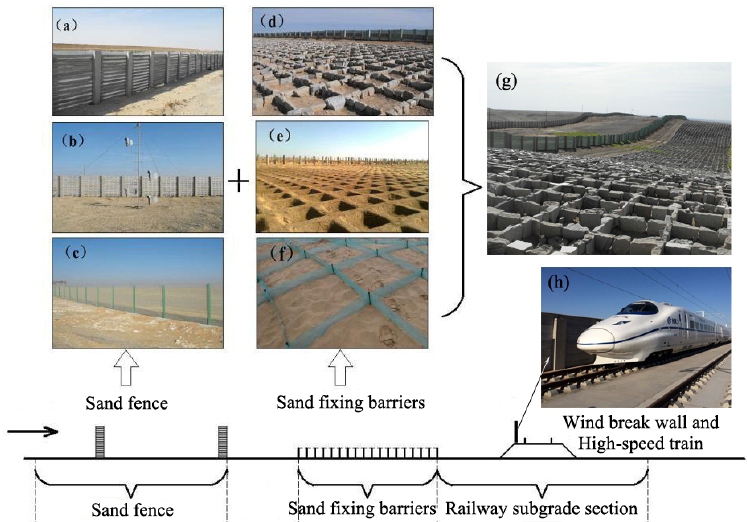
Figure A1. ( a – c ) Sand fences, ( d – g ) sand-fixing barriers, and ( h ) wind-break